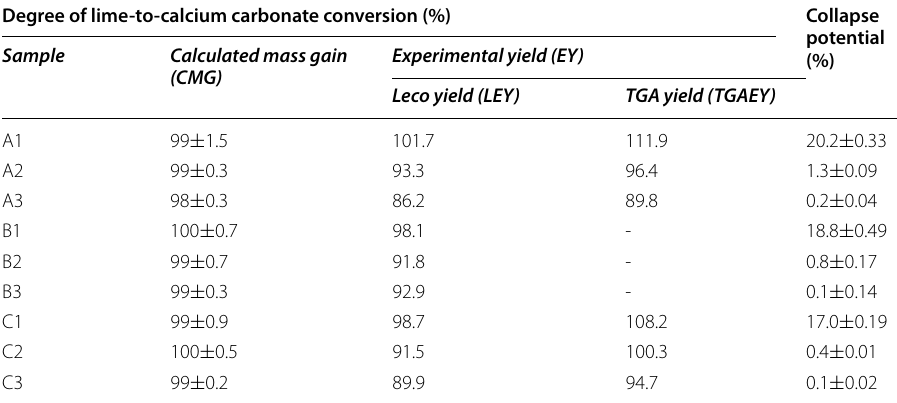
Table 2 Summary of the degree of lime-to-carbonation conversion as evaluated by the different methods, plus collapse potential values of manufactured samples Degree of lime-to-calcium carbonate conversion